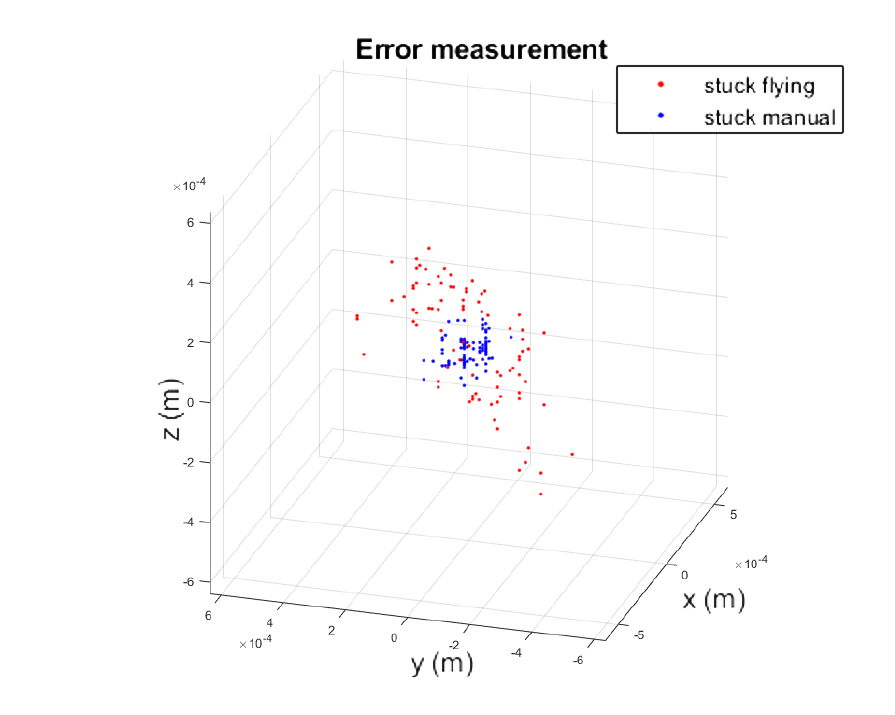
Figure 8. Comparison of the prism of the total station during flying inspection and manual